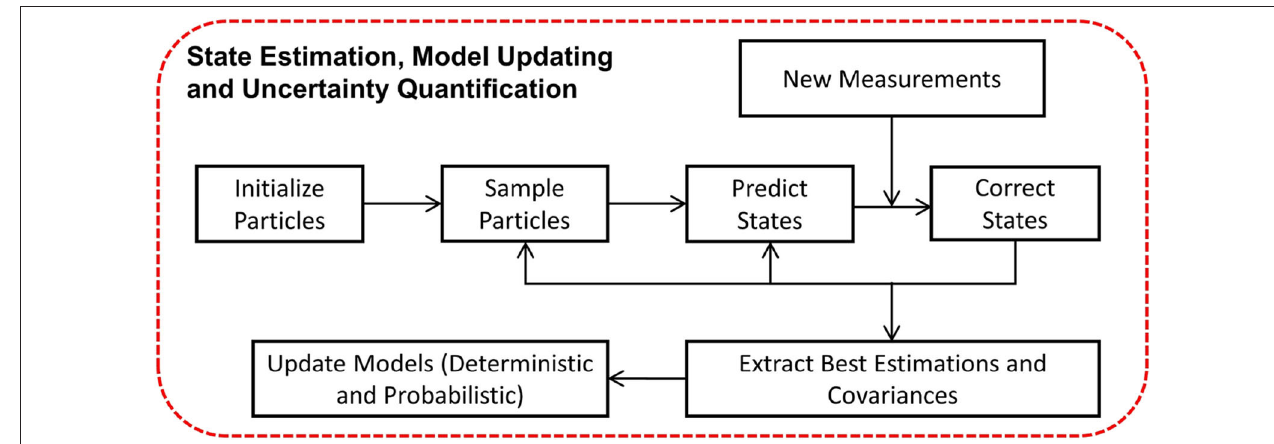
FIGURE 5 | Workflow of particle filter for model updating and uncertainty